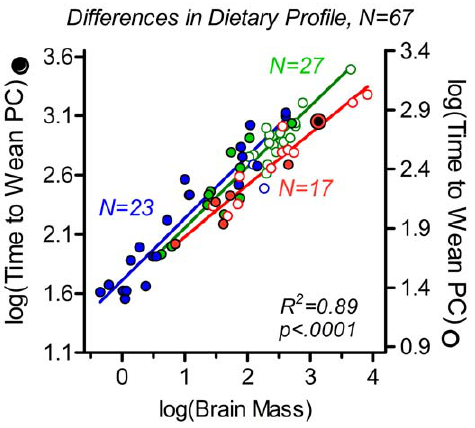
Figure 5. Time to weaning in humans is quantitatively predictable from a carnivorous diet. Predictions of time to weaning in humans based exclusively on species with a carnivorous (left panel, red) or a non-carnivorous diets (right panel, blue-green) were compared to a global sample of human natural fertility societies, shown as open circles (N=46). Note that human Brain Mass is equal for all individual data points, but a scattered plot was used in order for the reader to be able to distinguish different data points with identical time to weaning. Solid colored lines: regression lines illustrating predicted mean values for time to weaning in carnivorous (red) and non- carnivorous (blue-green) species (omnivores and herbivores were pooled; cf. Fig. 4); dashed lines: 90% prediction lines. Long black horizontal line: mean value of time to weaning of the 46 human natural fertility societies; short black lines: + / 2 1SD [5]. See main text for prediction of time to weaning in humans based on the full model.